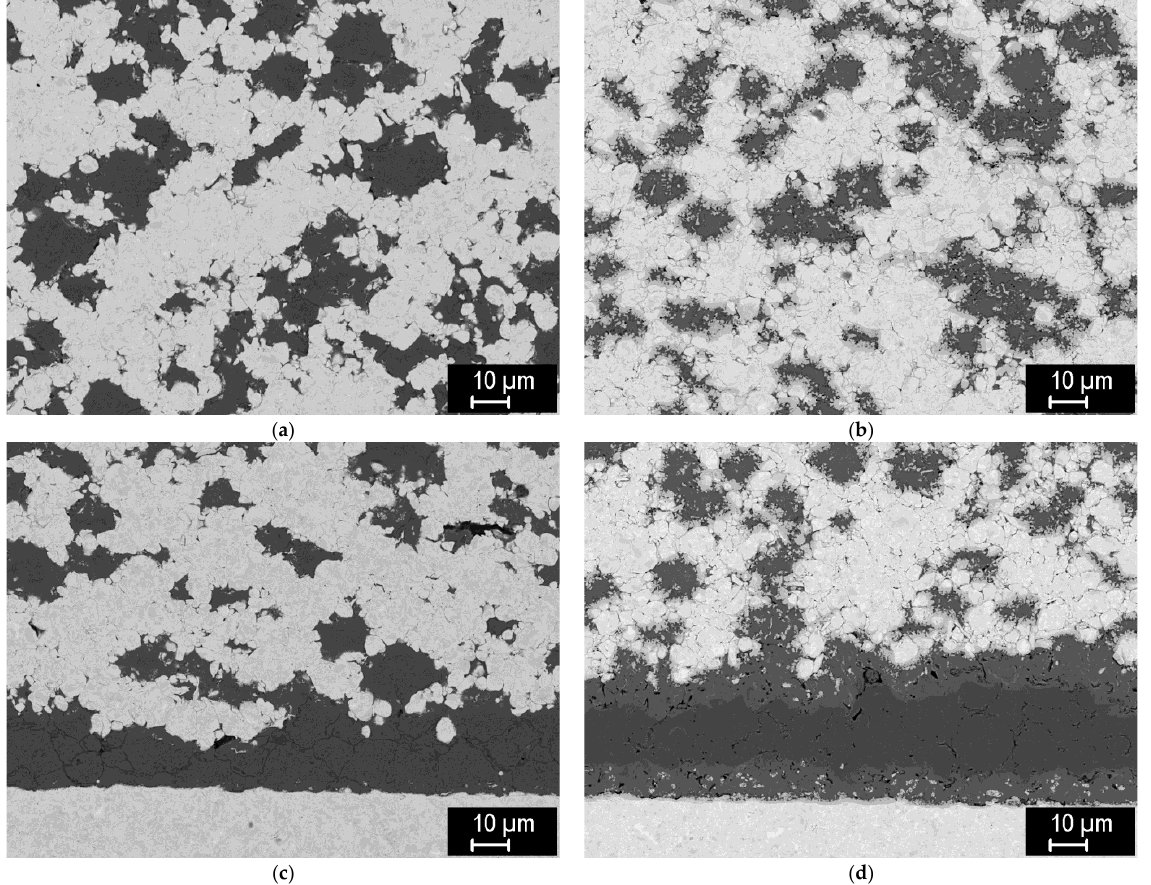
Figure 17. Tungsten pellet with a 60/40 mixed layer with finer tungsten powder. ( a ) Detail of the composite layer, sintered at 1000 °C; ( b ) detail of the composite layer, sintered at 1100 °C; ( c ) detail of the composite-tungsten interface, sintered at 1000 °C; ( d ) detail of the composite-tungsten interface, sintered at 1100 °C.